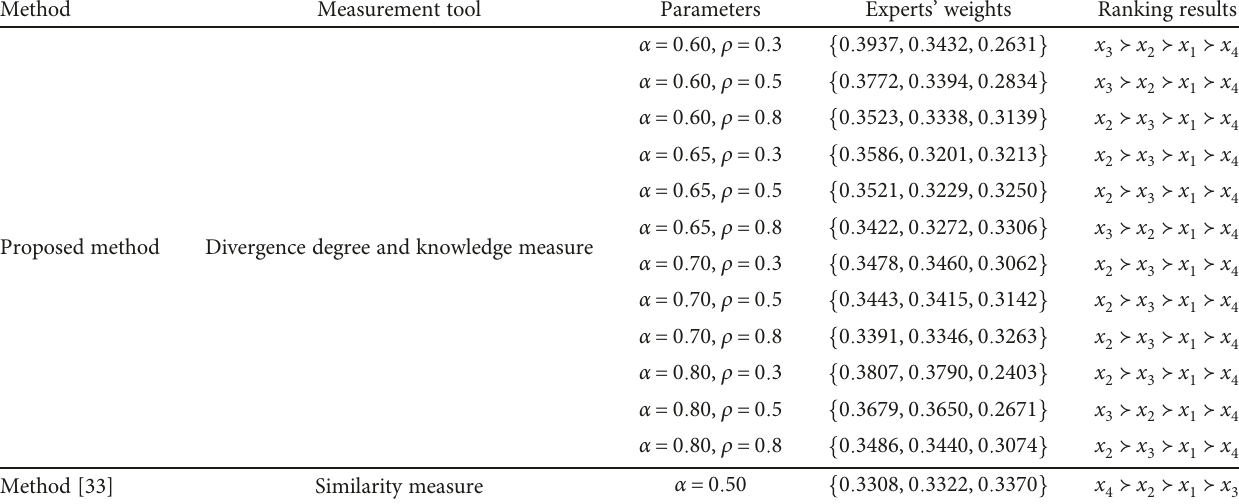
Table 17: Comparison with the method in